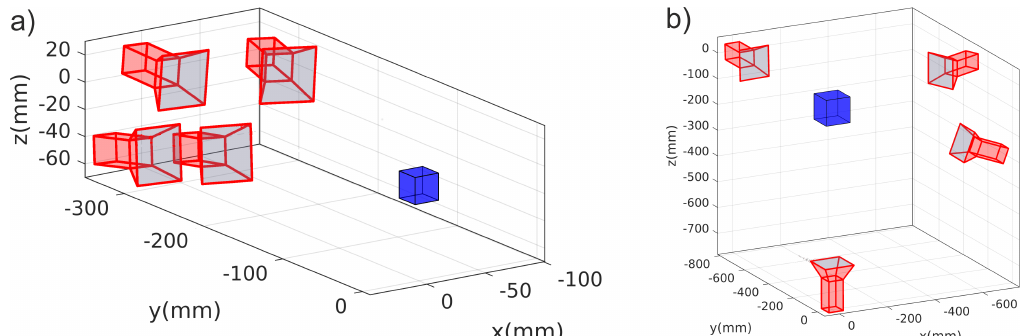
Figure 1. Two different possibilities for orienting four cameras. In ( a ), a narrow-angled setup is shown. This setup can be used in applications where only a single optical access to the investigated object is possible. In ( b ), the setup is wide-angled instead. This positioning can be used when different optical paths allow investigation of an object from very different angles. The blue box visualizes the observation volume, which is enclosed in a vacuum chamber in laboratory